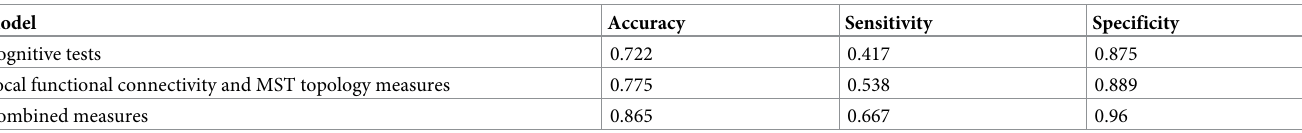
Table 7. Overview of classification